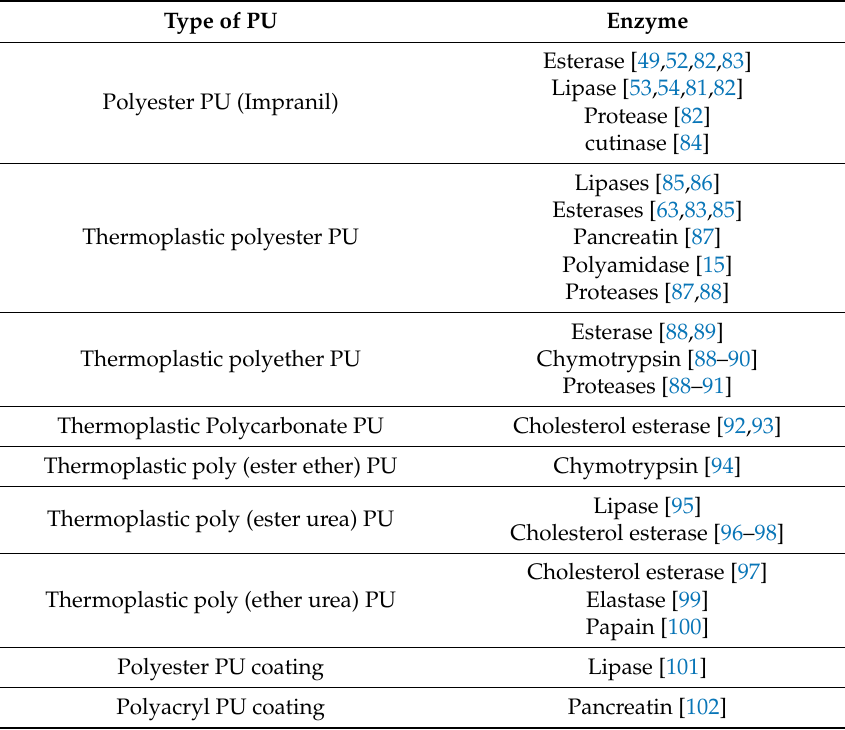
Table 4. Enzymes degrading di ff erent kinds of